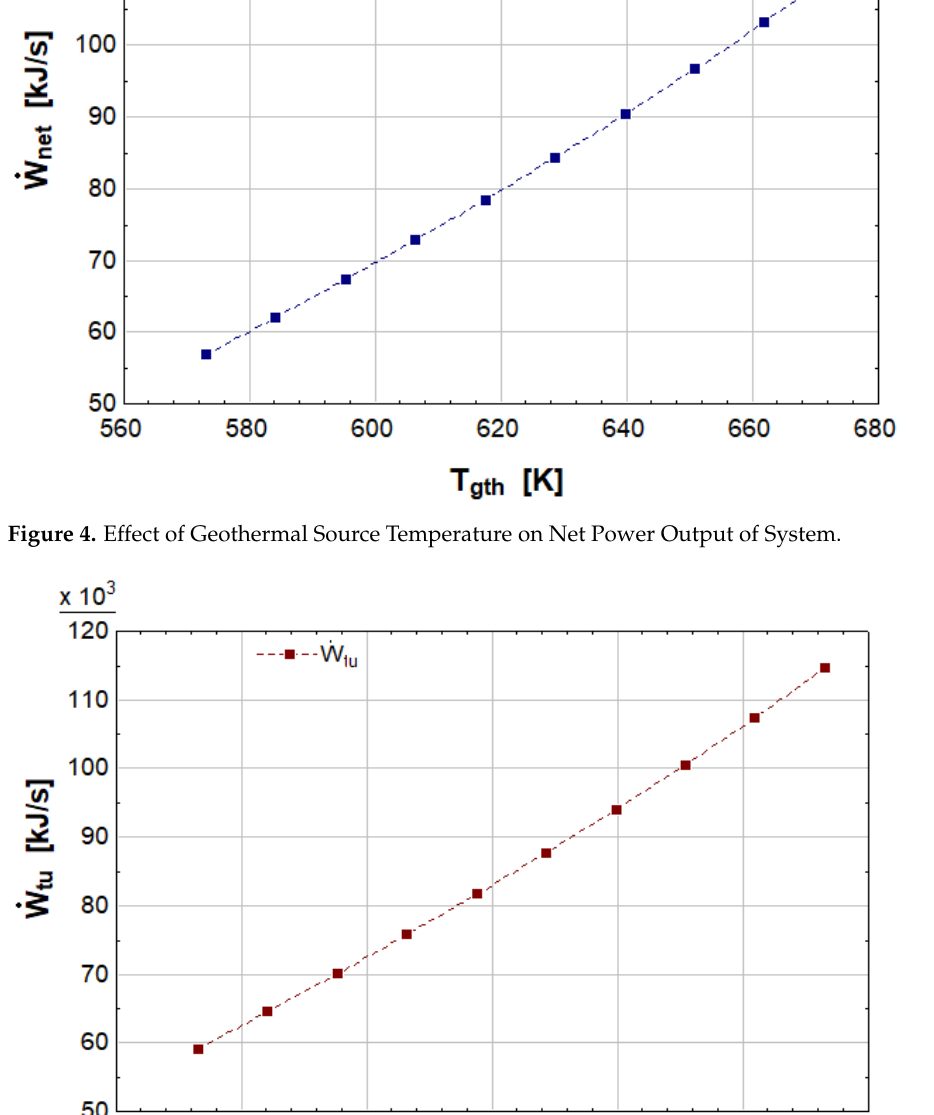
Figure 4. Effect of Geothermal Source Temperature on Net Power Output of System .